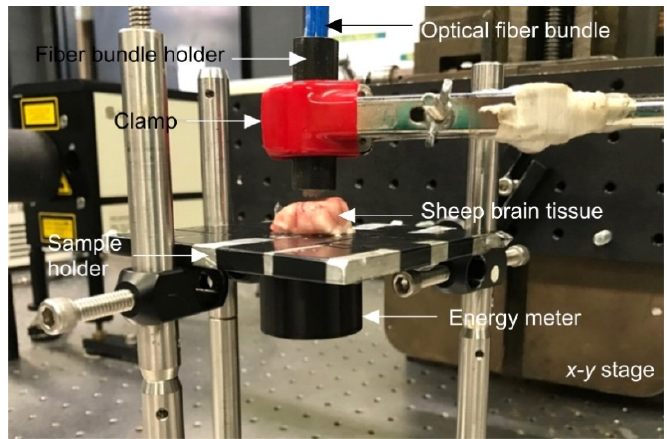
Figure 2. Experimental setup of the optical transmittance characterization to find the thickness of the tissue-mimicking phantom that is optically equivalent to brain tissue.